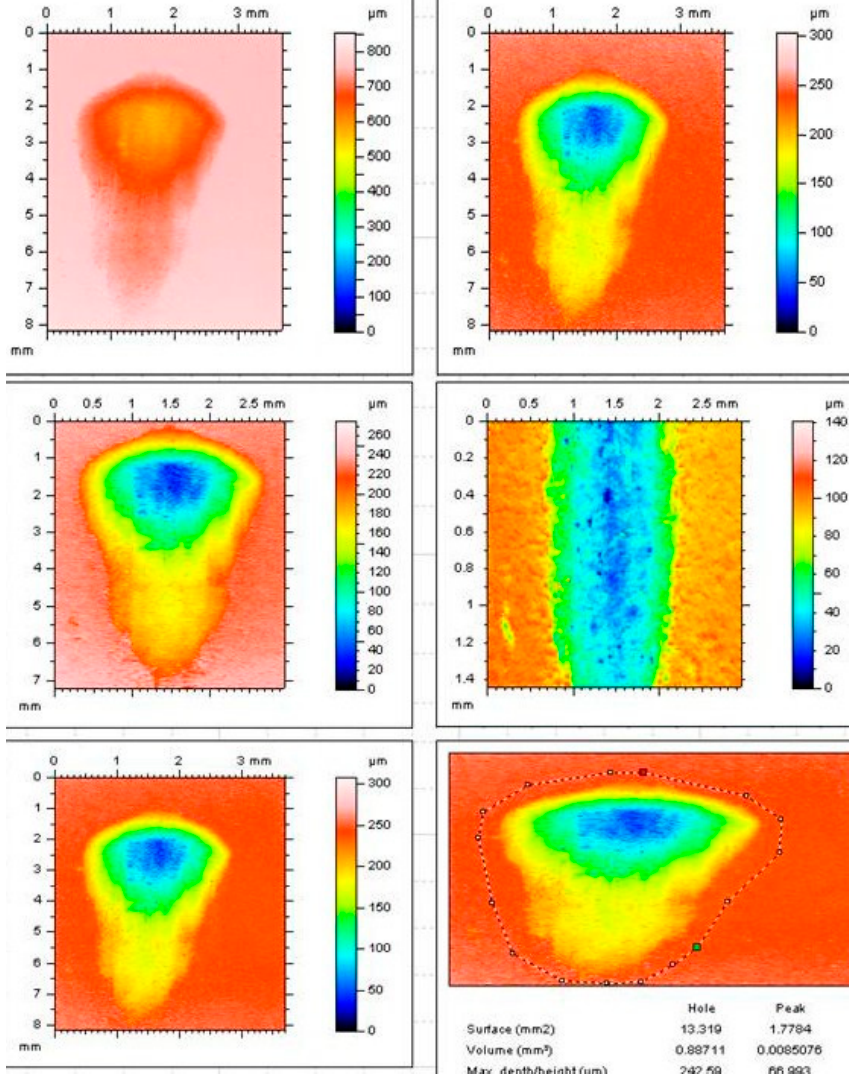
Figure 4. Tear-drop shaped wear facets scanned using a Talysurf optical profilometer (TaylorHobson Precision, Leicester, UK). The wear volume was determined from the wear facet produced by the OHSU wear simulator showing the abrasion region (yellow area, 40–60% of the wear facet length) and the attrition region (blue and green area, 80–90% of the wear facet length).